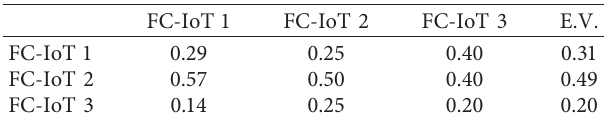
Table 6: Pairwise comparison for architecture 1.